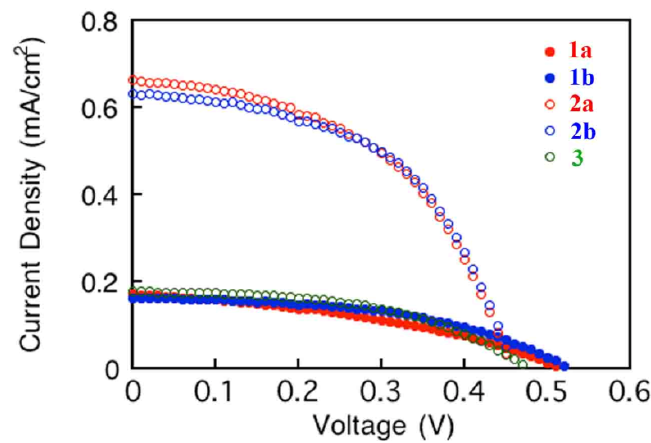
Figure 6. Photocurrent density – voltage ( J – V ) curves for dye-sensitized solar cells (DSSCs) with the coordination polymers 1a , 1b , 2a , 2b and 3 .